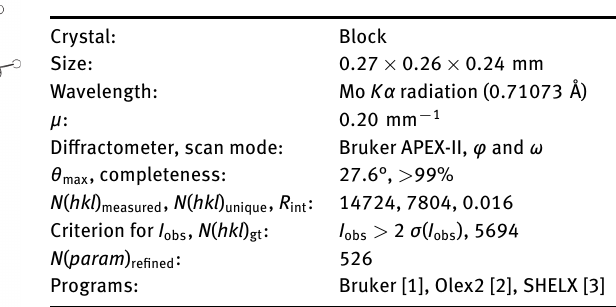
Table 1: Data collection and handling.